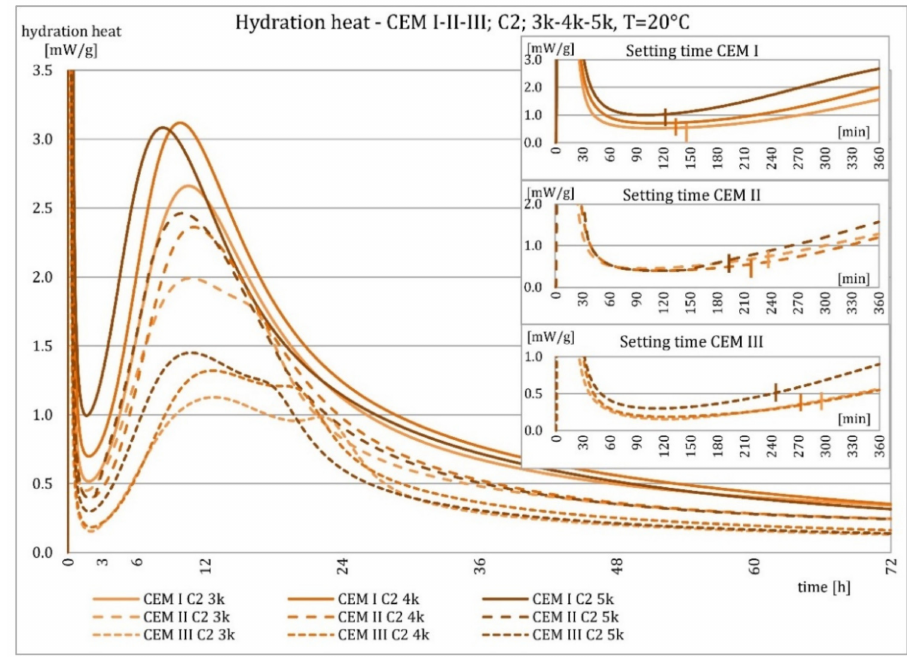
Figure 10. Hydration heat of C2 clinker based non-modified cements CEM I, CEM II/B-S, CEM III/A at 20 ◦ C.